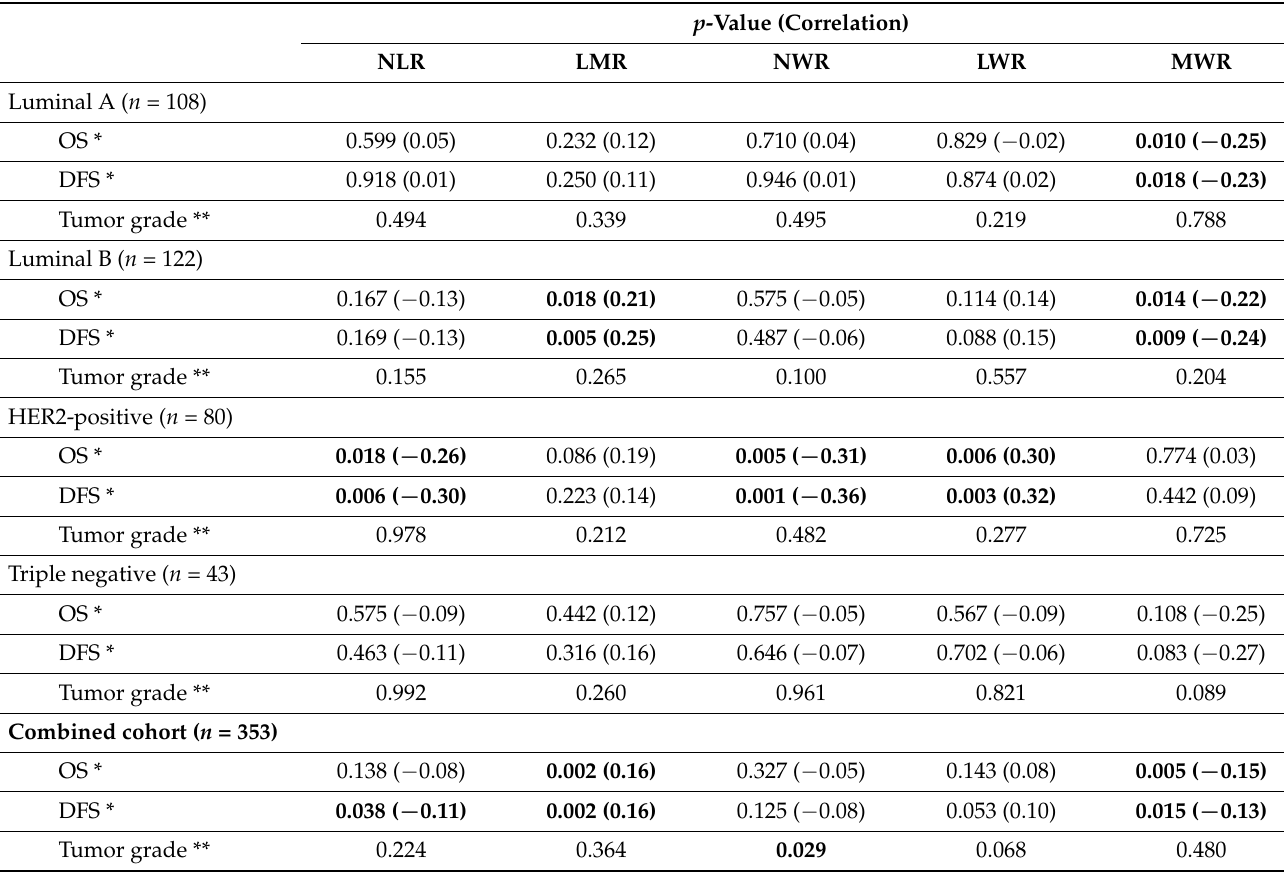
Table 4. Correlations between clinicopathological details and immunocyte